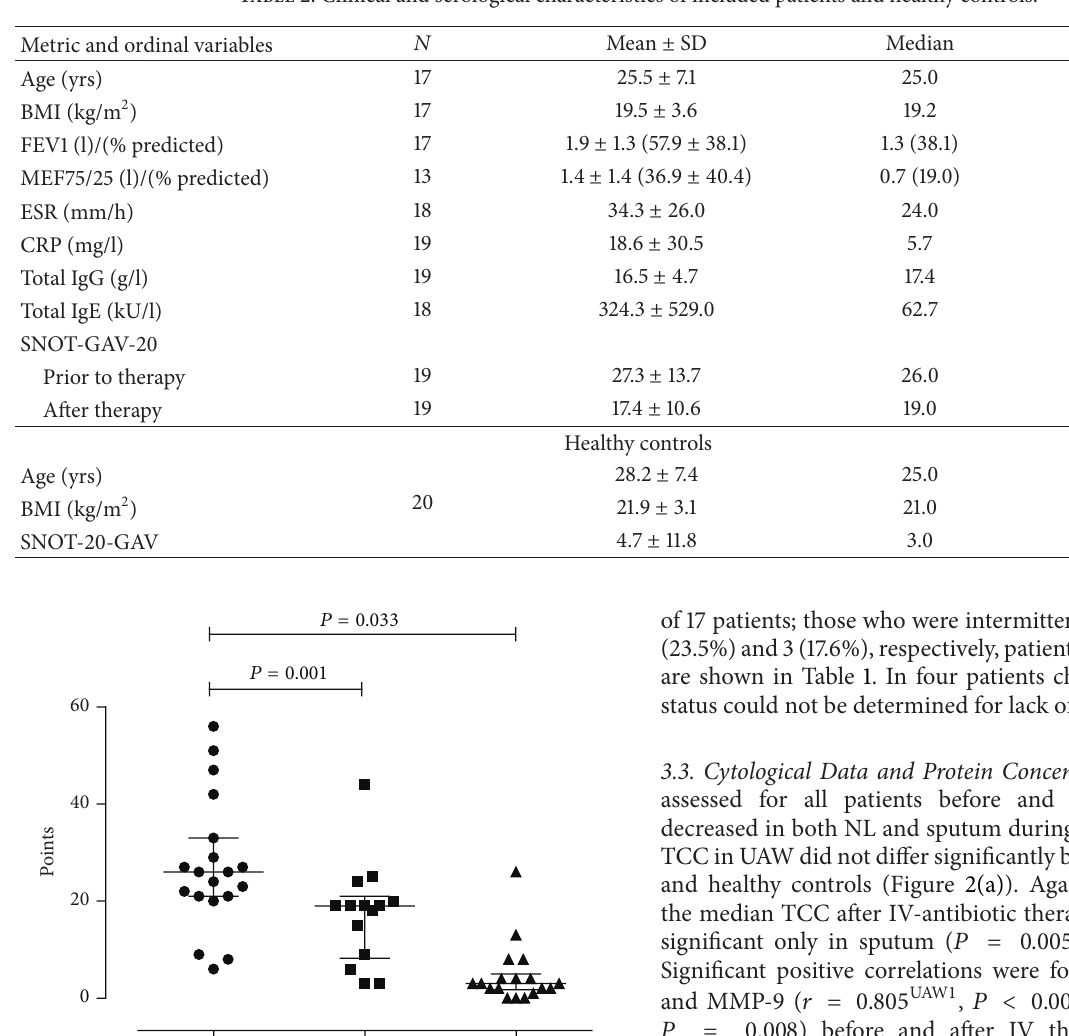
Table 2: Clinical and serological characteristics of included patients and healthy controls.